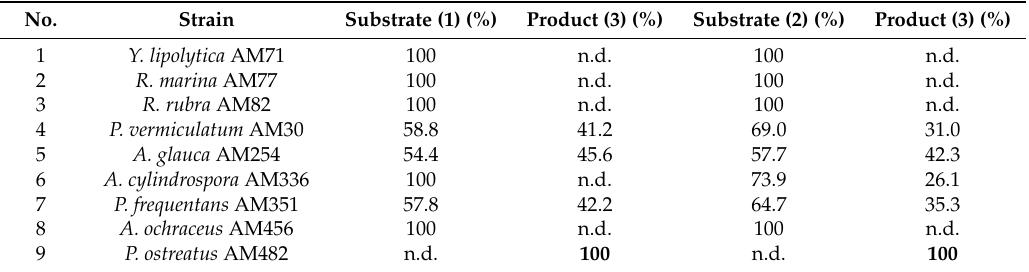
Table 1. Results of the screening biotransformation of bromo- and iodolactones 1 and 2 after nine days (according to GC-FID).